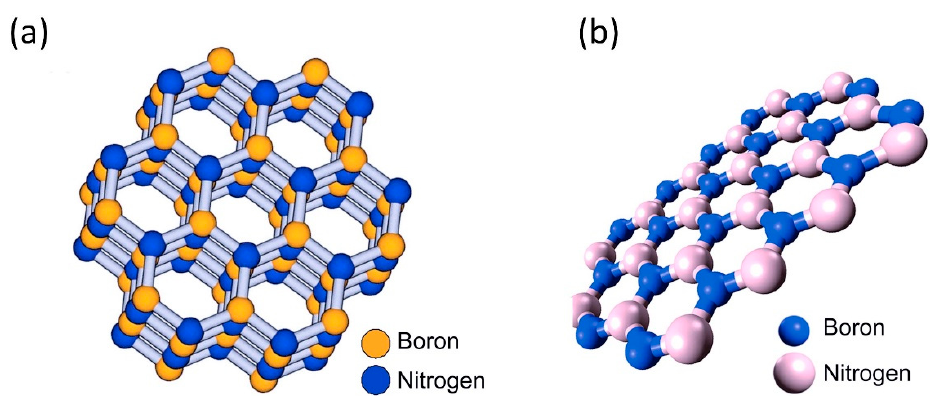
Figure 12. Illustration of the atomic structure of hexagonal boron-nitride ( a ) in a bulk structure, ( b ) in a monolayer structure. Reprinted from [179], with the permission of AIP Publishing.